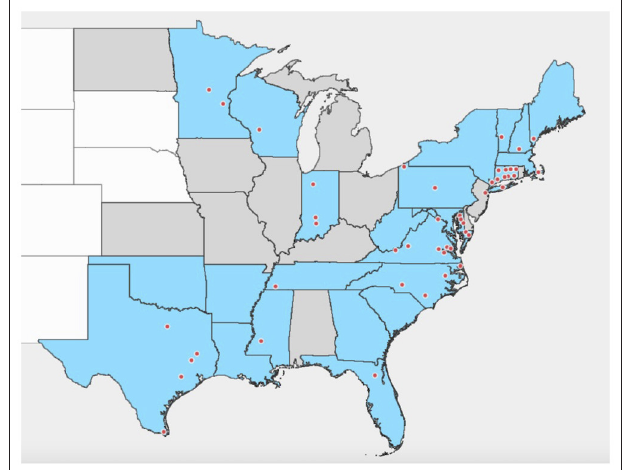
FIGURE 1 | Distribution of detections of R. buchneri and “Rickettsial endosymbiont of Ixodes scapularis ” in Ixodes scapularis in the United States of America. Shaded area indicates states with established populations of Ixodes scapularis in 2016 based on Eisen and Eisen (1). States shaded blue are those where R. buchneri /REIS has been detected in I. scapularis ; records with county-level data are shown by dots. Based on data from references published 2007–2021 (18–23,